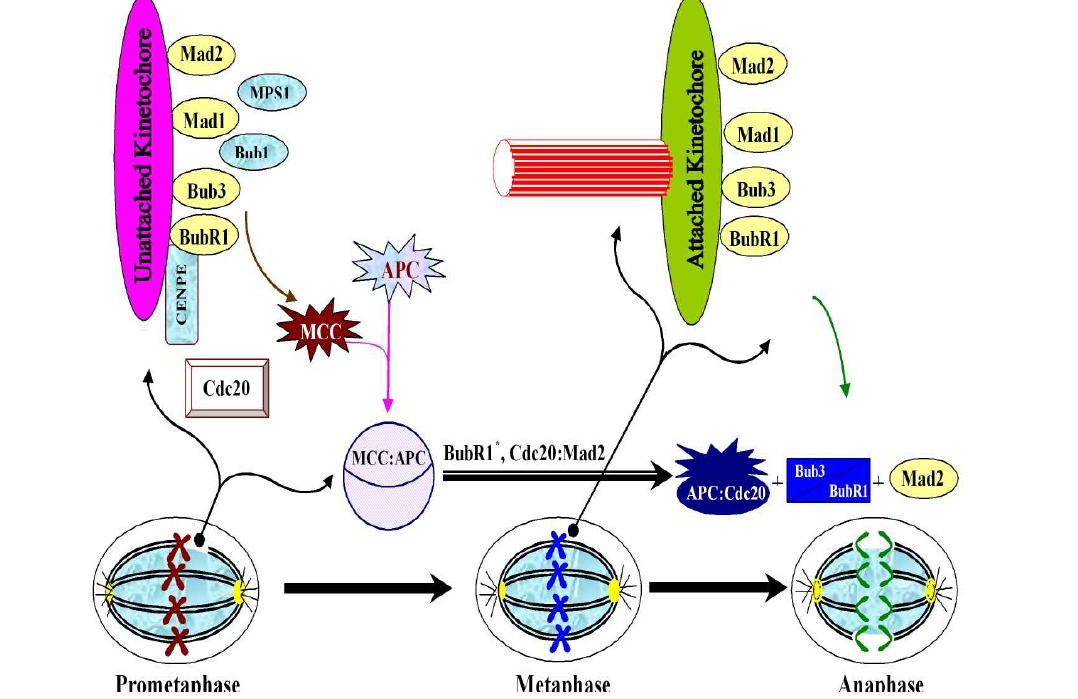
Figure 1: Scheme of reactions and localizations. As long as a kinetochore is unattached, MPS1, Bub1, CENPE, (and further players) mediate activation reactions at the kinetochore (upper left). When the kinetochore is attached, these reactions stop (upper right). As long as there is a single unattached kinetochore, MCC and APC form a complex (lower left, prometaphase to metaphase). When the last kinetochore has attached, the APC:Cdc20 complex can form and triggers exit to anaphase (lower